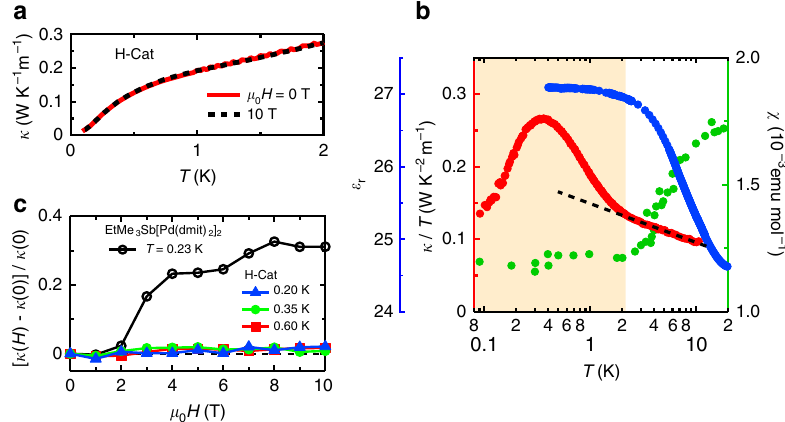
Fig. 4 Paraelectric and spin liquid phases of H-Cat. a Temperature dependences of κ ( H ) for H-Cat at 0 and 10 T. b A combination of the temperature dependences of the dielectric constant ϵ r (blue, left axis), the thermal conductivity divided by temperature κ / T (red, left axis) and the magnetic susceptibility χ (green, right axis) for H-Cat. The values of χ are taken from ref. 5 . The dashed line is an eye guide. The shaded region represents the QPE and QSL phases. c Magnetic fi eld dependence of the thermal conductivity κ ( H ) normalized by the zero fi eld value [ κ ( H ) − κ (0)]/ κ (0) for H-Cat ( fi lled symbols) and EtMe 3 Sb[Pd(dmit) 2 ] 2 (open circles)